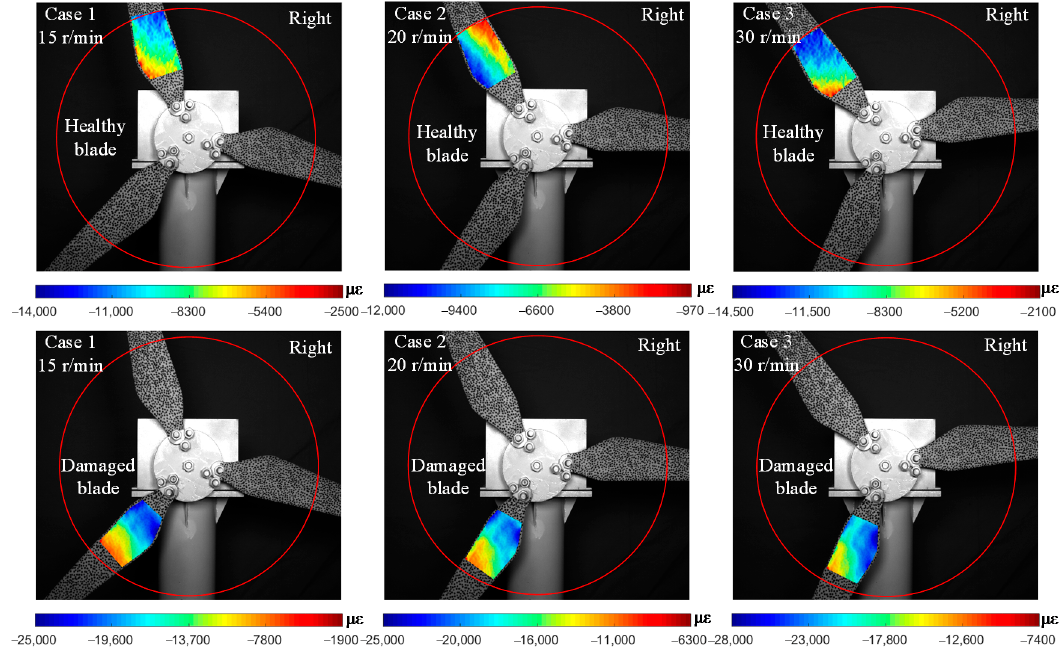
Figure 13. Strain distribution in x -direction of the measured blade when rotated to the horizontal right orientation.